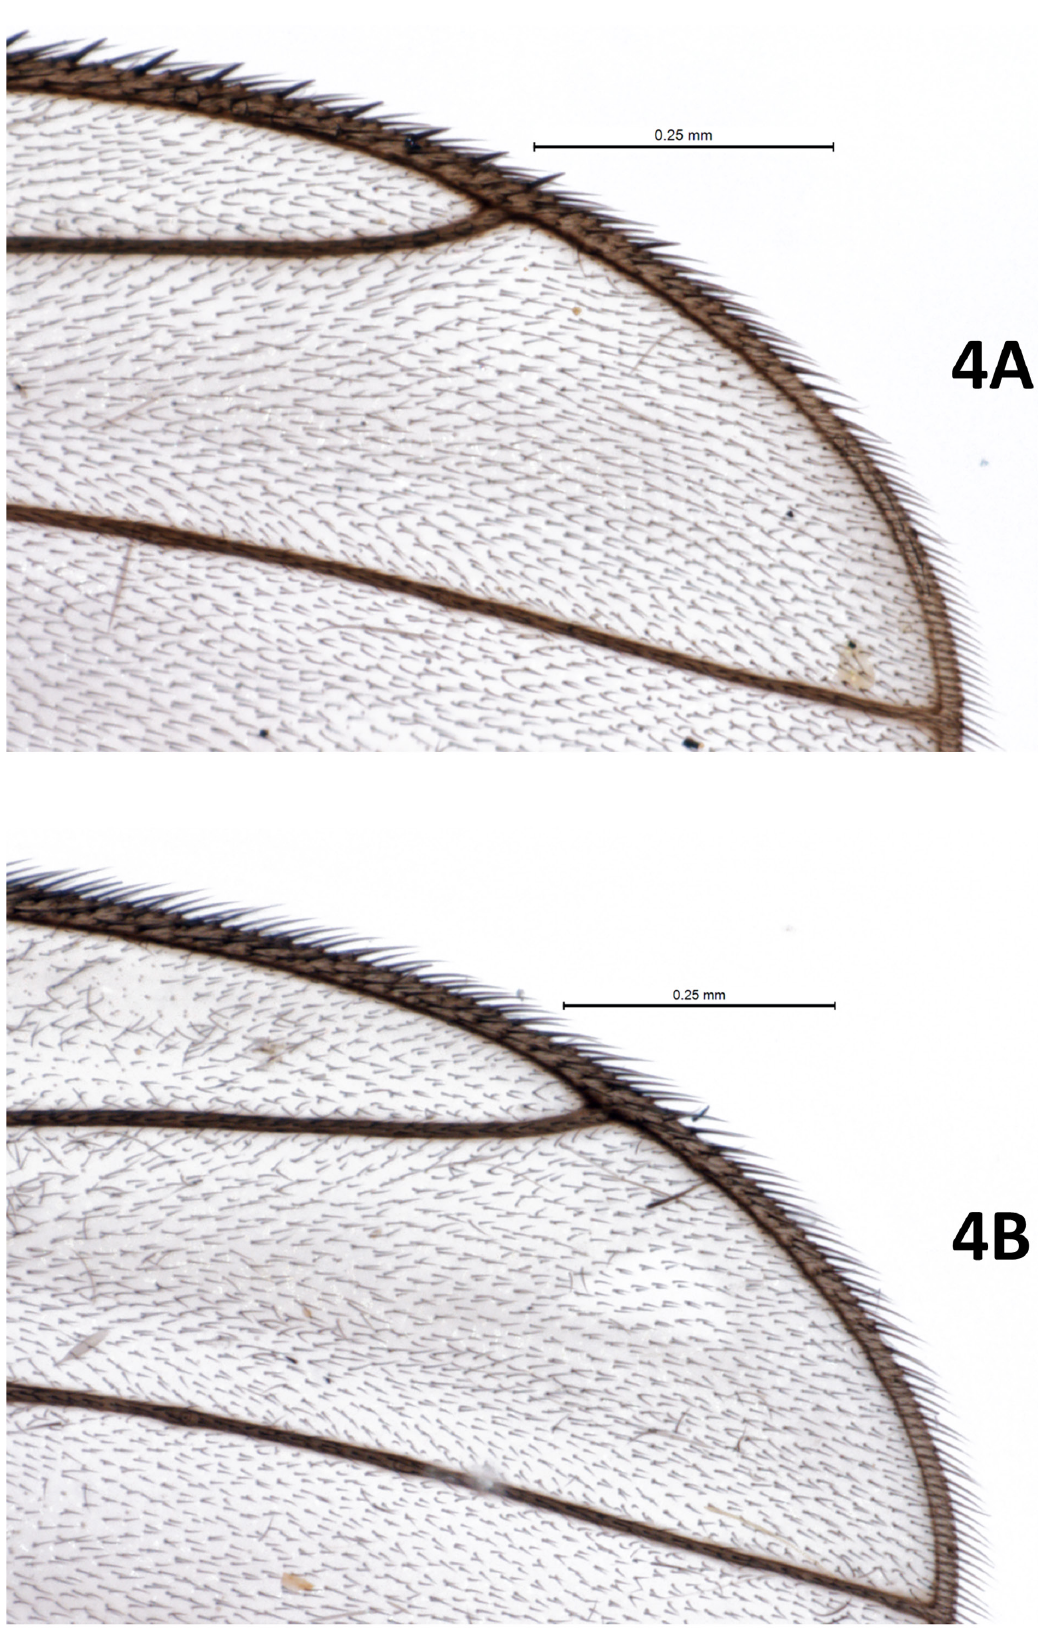
Fig. 4. Australofannia spiniclunis Pont, 1977, detail of wing showing CS3‒4, dorsal view. A . ♀. B .